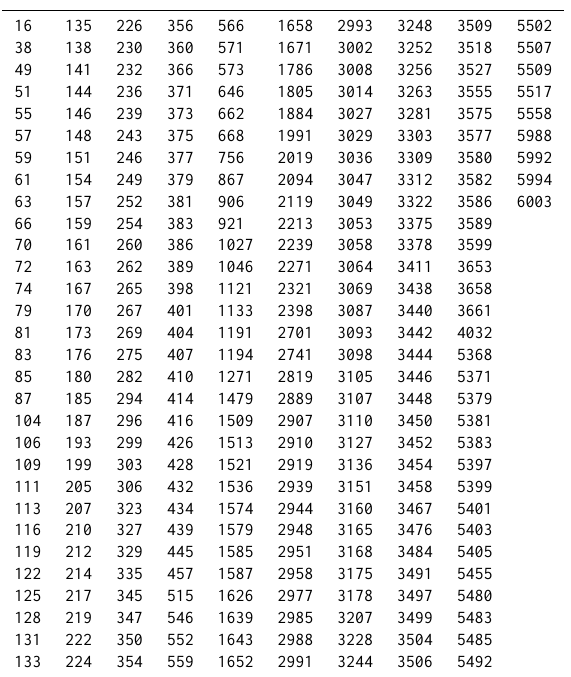
Table 2. Listed below are the 279 channels in IASI corresponding to atmospheric temperature and humidity. The numbers indicate the order in which the channels were chosen in current data assimila-